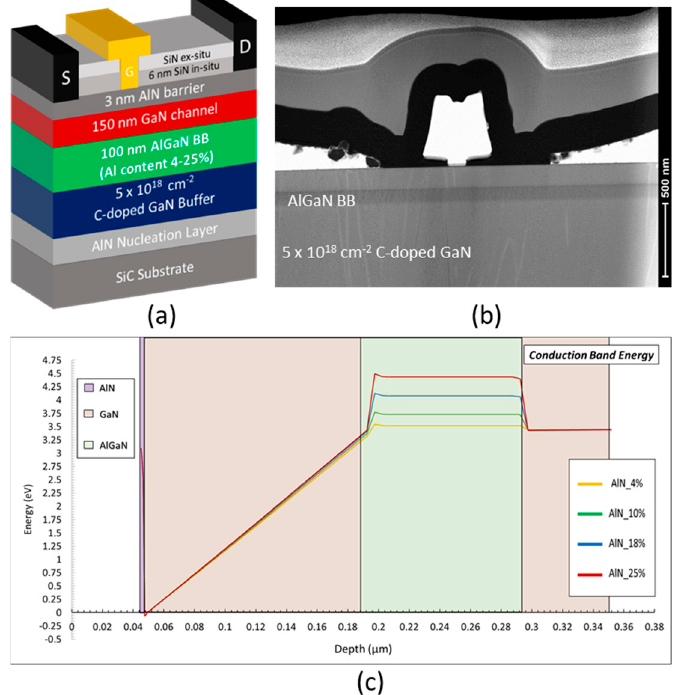
Figure 1. Schematic cross-section of the AlN/GaN HEMT structure based on a thin AlGaN back barrier with various Al-content (4% to 25%) ( a ), TEM view of the device showing the epitaxial stack as well as the ohmic and Schottky contacts ( b ) and the energy band diagram of the structures with different Al-content ( c ).